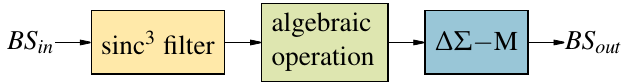
Figure 25. Generalized nonlinear ∆Σ SP operation based an short sinc filters and DSP.